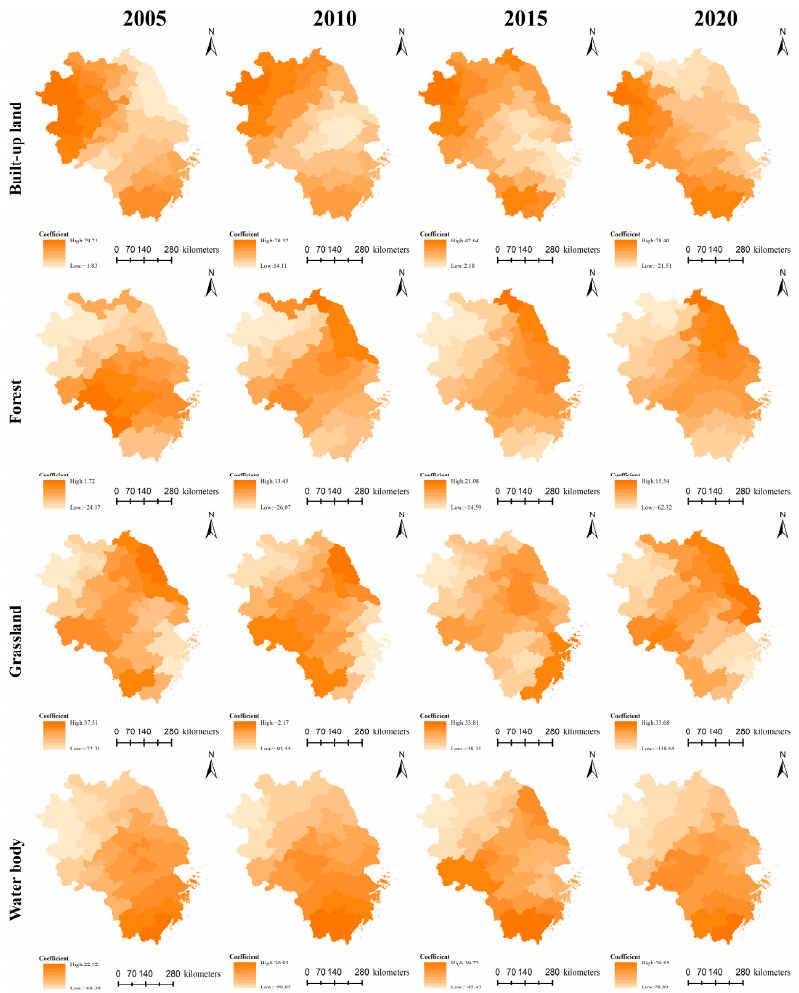
Figure 12. Coefficient of the GWR between UTCI and LUCC types in YZD.